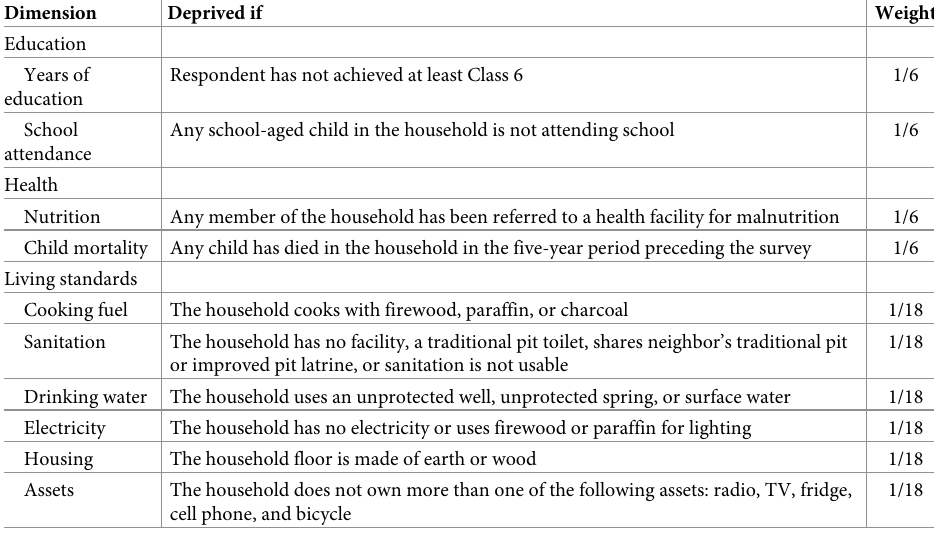
Table 1. Components of Household Deprivation Score